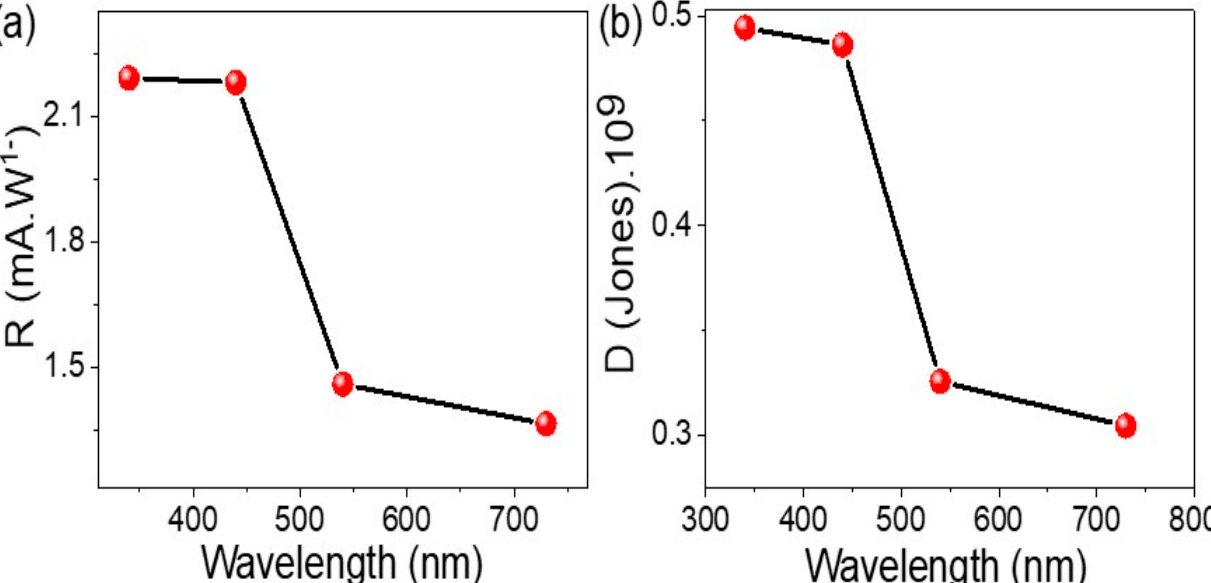
Figure 7. The photodetector ( a ) R and ( b ) (D) efficiency with the optical wavelengths from 340 to 730 nm. Table 1. The performance of the photodetector in comparison with published literature.